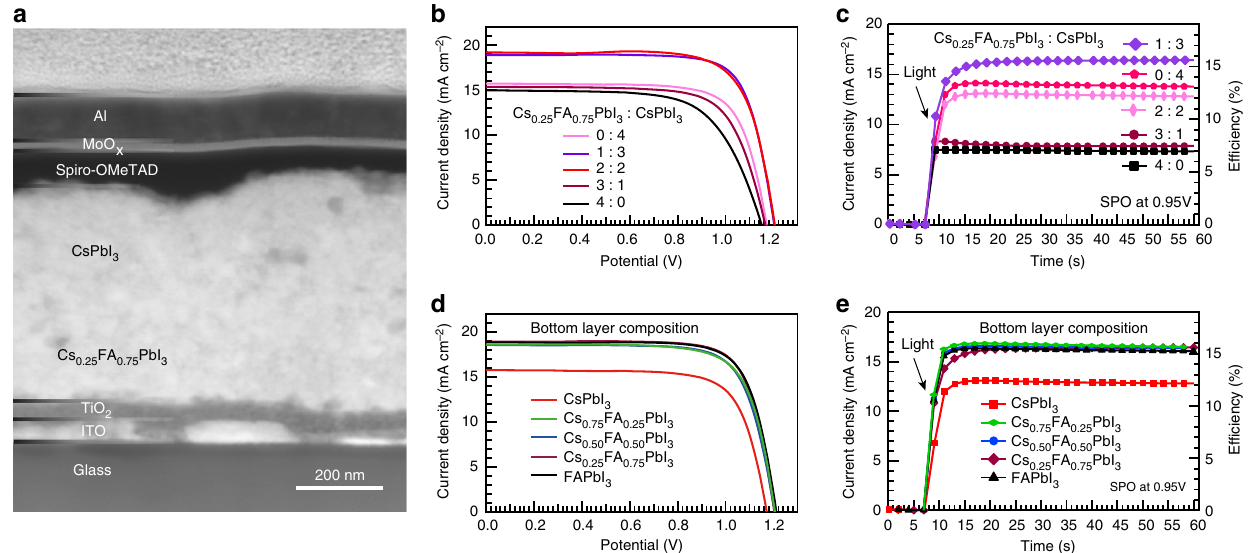
Fig. 3 Photovoltaic performance of solar cells. a Cross-sectional STEM-HAADF image of devices with the structure of Glass/ITO/TiO 2 /Cs 0.25 FA 0.75 PbI 3 / CsPbI 3 /spiro-OMeTAD/MoO x /Al. b , c J – V curves recorded by reverse scans (from open circuit to short circuit) and SPO at 0.95 V of devices with different thickness ratio of Cs 0.25 FA 0.75 PbI 3 layer to CsPbI 3 layer in the perovskite QD absorber, respectively. d , e J – V curves measured via reverse scans and SPO at 0.95V of devices with different compositions of the bottom layer in the perovskite QD absorber where the heterojunction position is constant Table 1 Photovoltaic parameters of solar cells Thickness ratio (Cs 0.25 FA 0.75 PbI 3 : CsPbI 3 )